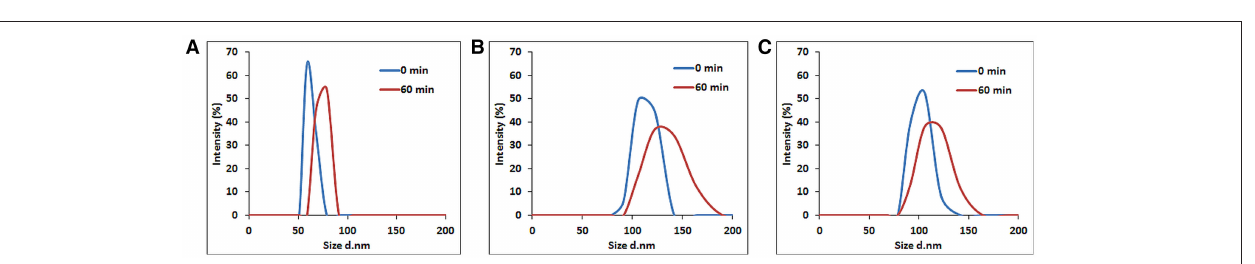
Frontiers in Bioengineering and Biotechnology |